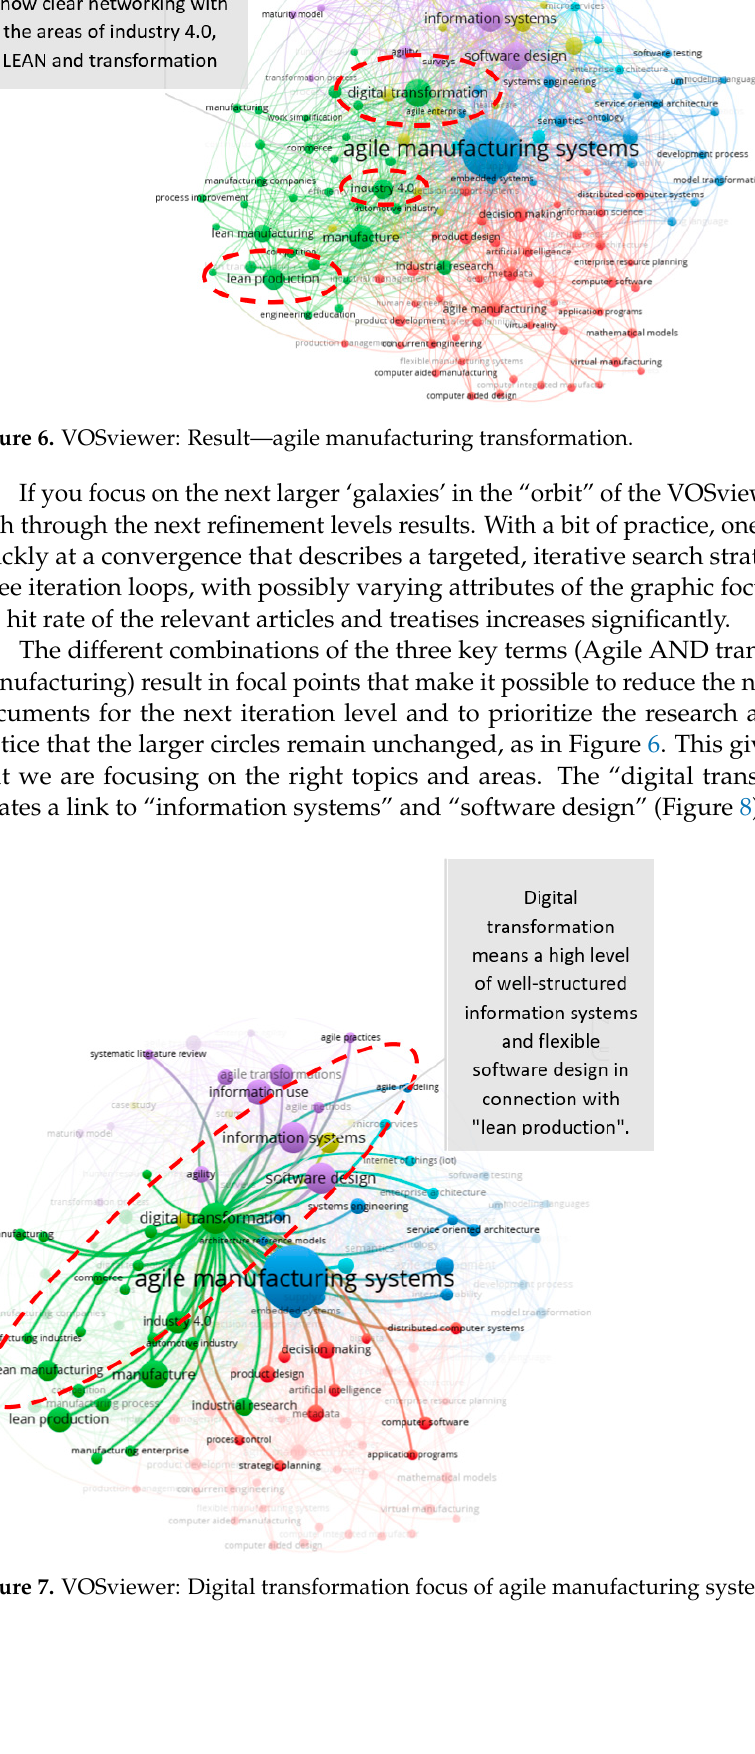
Figure 8. VOSviewer: One focus of agile manufacturing systems is digital transformation.